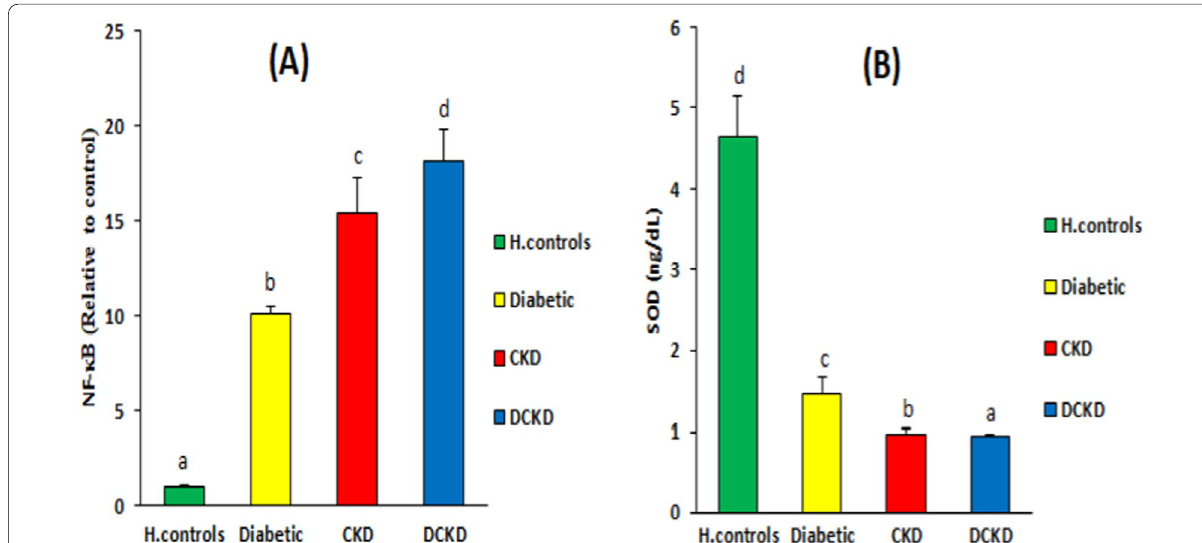
Fig. 2 The levels of A NF‑ κ B mRNA expression, B SOD activity in healthy control, diabetic, chronic kidney dysfunction (CKD), and diabetic chronic kidney dysfunction (DCKD) groups. Data are represented as mean SD. Different letters indicate significant differences ( p < 0.05). H.: Healthy, SOD: ± superoxide dismutase activity, NF‑ κ B: nuclear factor kappa